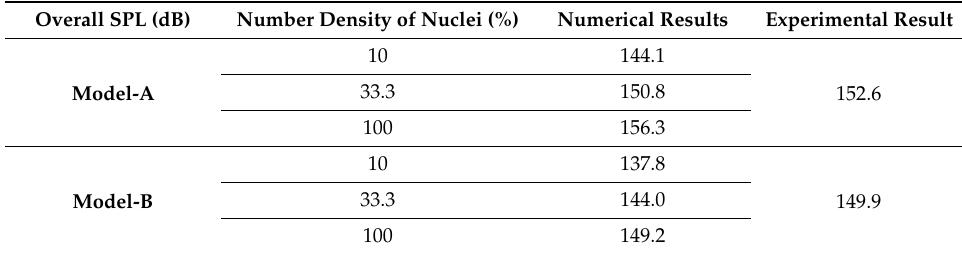
Table 7. Comparison of overall sound pressure levels (OASPL) between numerical and experimental results according to